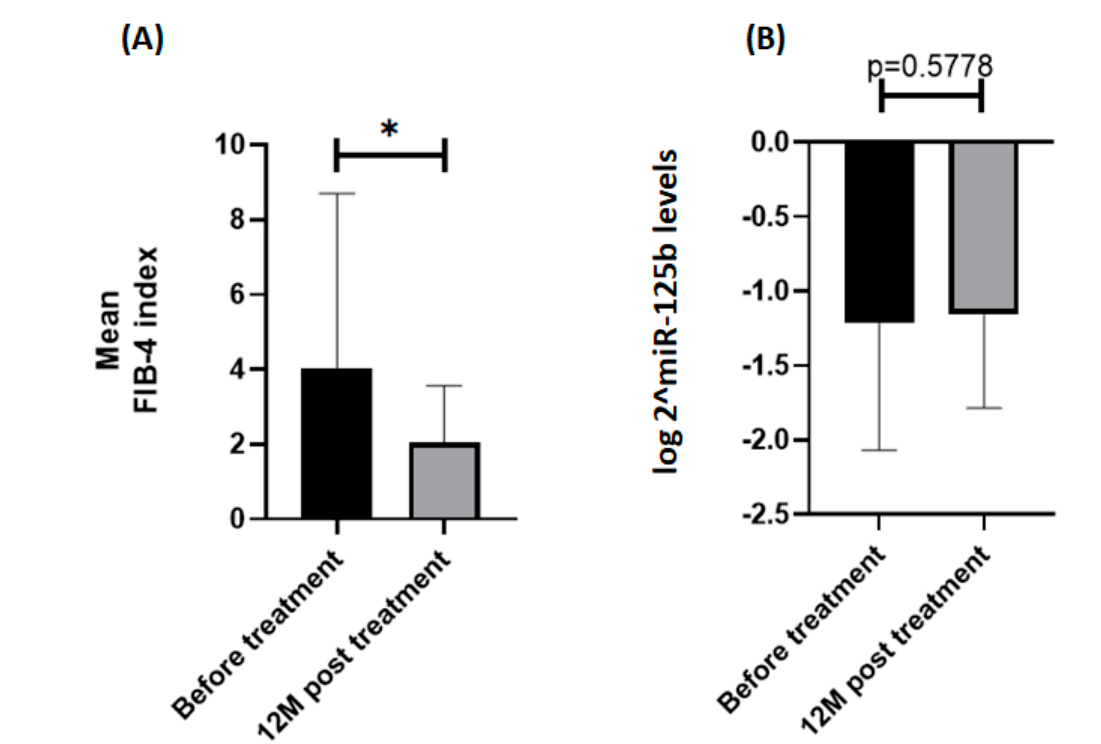
Figure 1. Comparing the differences in the ( A ) mean FIB − 4 index and ( B ) log 2^miR − 125b levels at the baseline and post − treatment. Error bars show mean ± standard deviation. p value from the Mann–Whitney test is shown. * = p < 0.05.